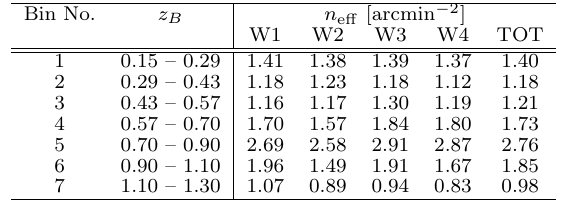
Figure 1. Stacked probability distribution of each unmasked galaxy per redshift bin (Joudaki et al. 2017). Each colour refers to a different bin, defined in Table 1.